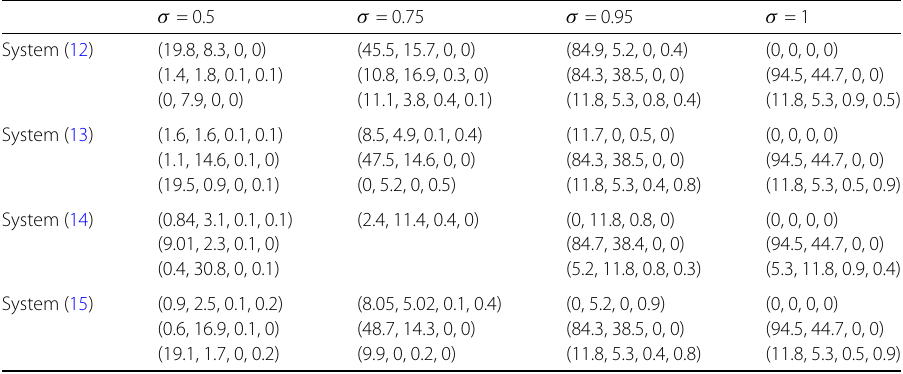
Table 1 Numerical equilibrium points for different values of the fractional index σ and α = 0.5 σ = 0.5 σ = 0.75